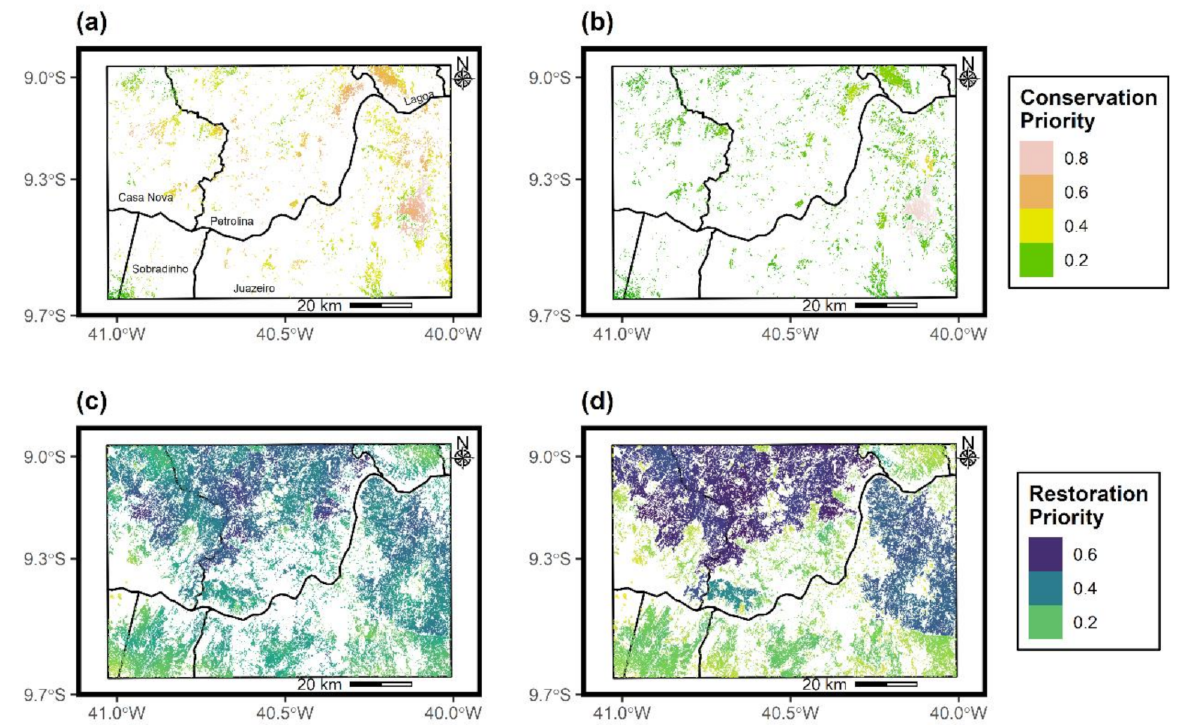
Figure 7. Conservation priorities of dense Caatinga patches for the different scenarios of index weightings in the MCDA: ( a ) Scenario 1, ( b ) scenario 2. Restoration priorities of open Caatinga patches for the different scenarios of index weightings in the MCDA: ( c ) Scenario 1, ( d ) scenario 2. Scenario 1 corresponded to the weights 0.6, 0.2 and 0.2 for CDI, dIIC and BC , respectively, and scenario 2 corresponded to the weights 0.2, 0.4 and 0.4 for CDI, dIIC and BC , respectively. The black lines represent the boundaries of the administrative